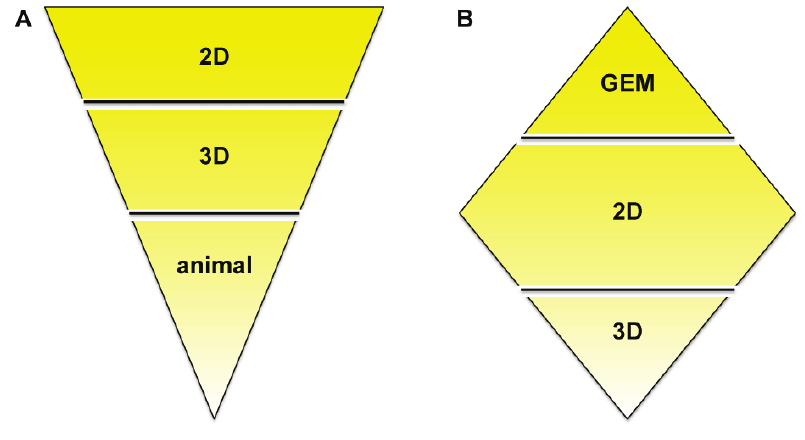
Figure 7. ‘ Upside- down triangle approach’ ( A ) and ‘diamond approach’ ( B